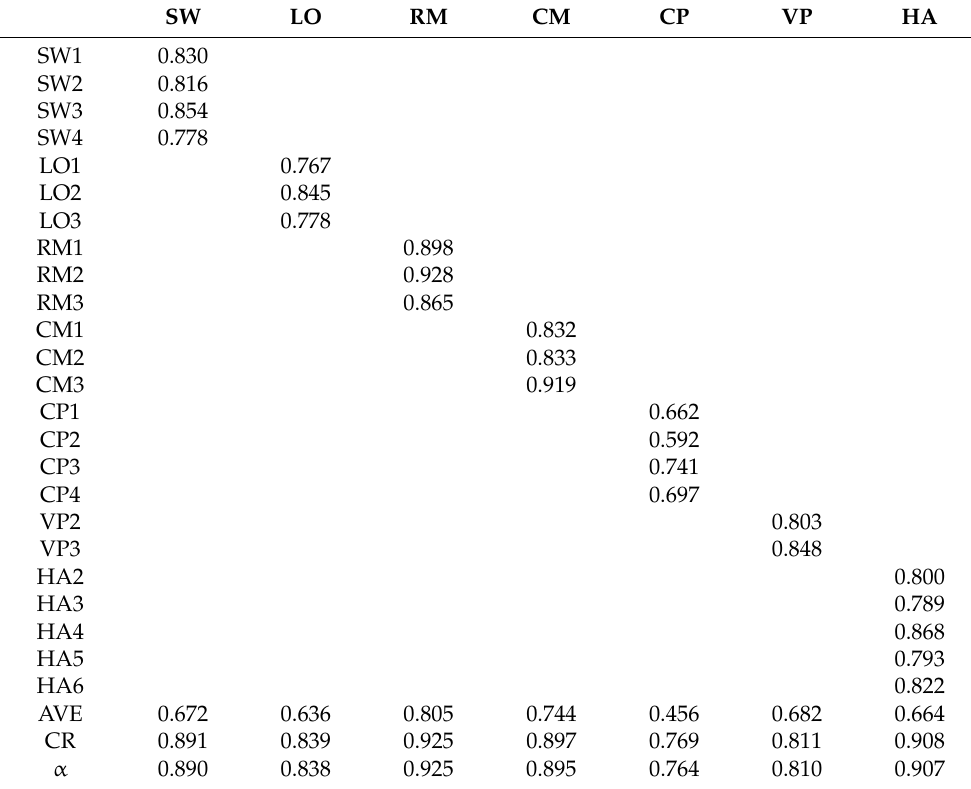
Table 2. Factor loadings, Cronbach’s α , AVE, and CR.